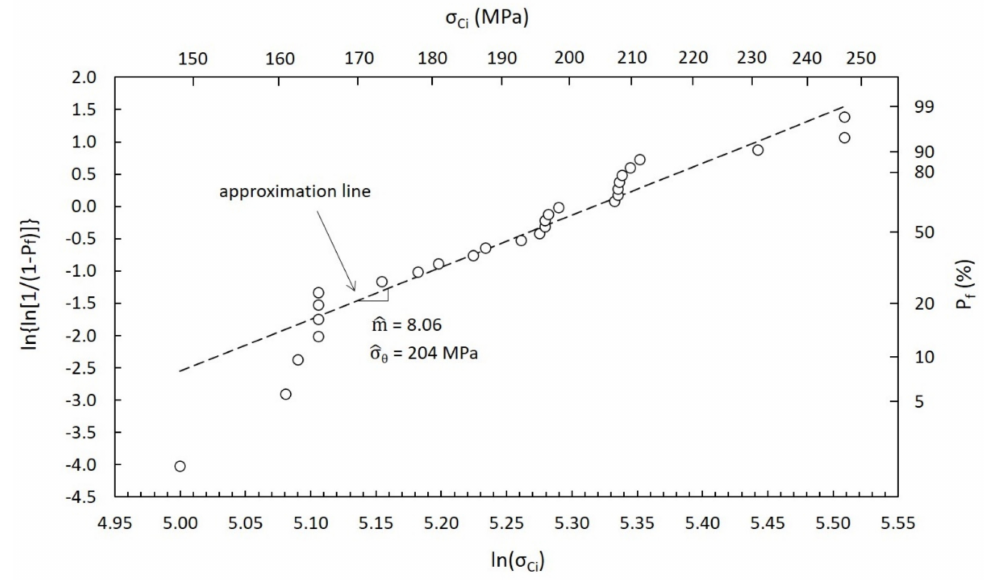
Figure 15. Weibull plot of strength data for SiC SP (RTPs